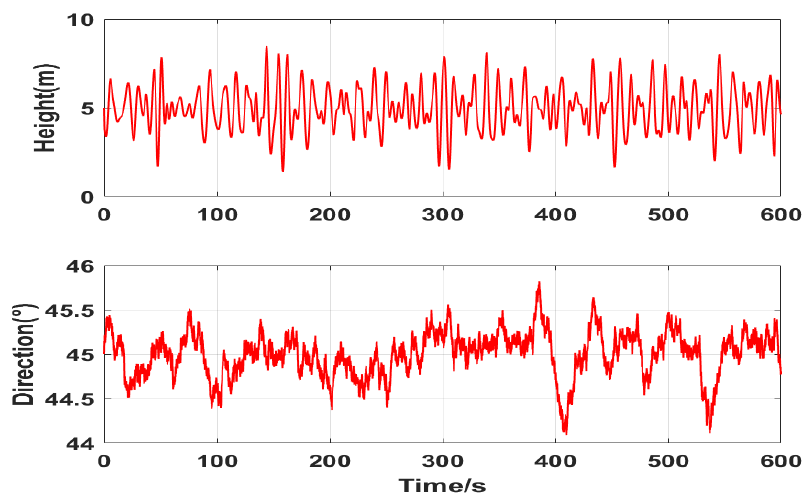
Figure 7. Simulation diagram of wave speed and direction.